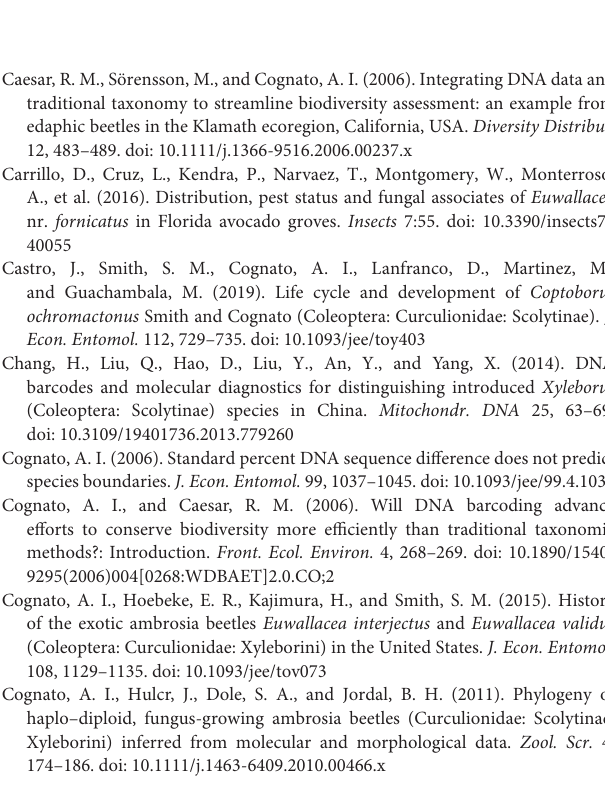
Supplementary Figure 1 | Neighbor-joining tree based on pairwise uncorrected “ p ” distances for COI for 490 Xyleborini specimens. Supplementary Figure 2 | Neighbor-joining tree based on pairwise uncorrected “ p ” distances for CAD for 429 Xyleborini specimens. Supplementary Table 1 | Xyleborini specimens included in this